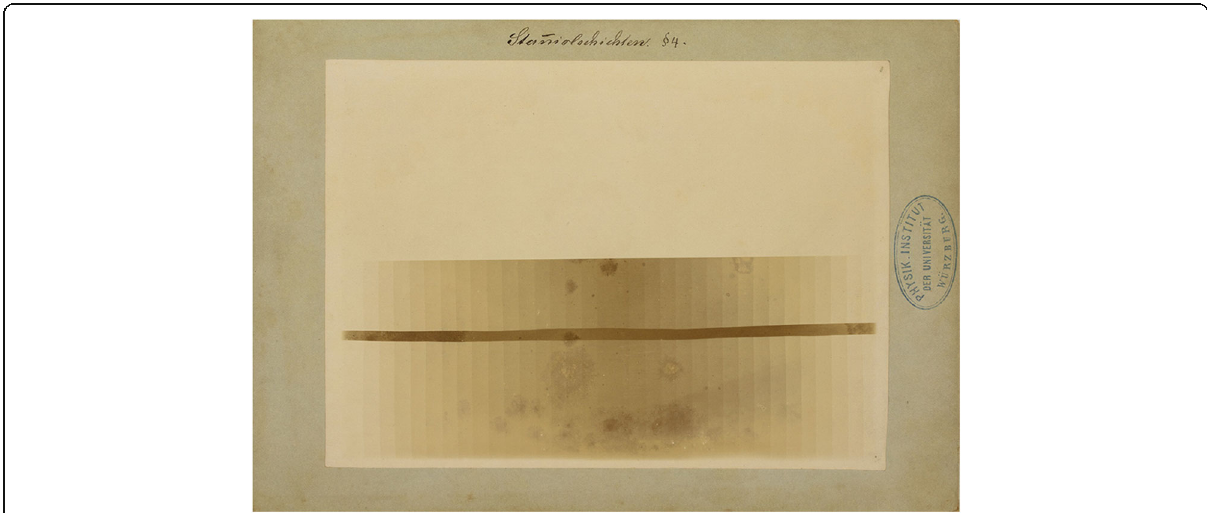
Fig. 5 Stacks of tin foil with various thicknesses. This image shows that the thicker the stack, the less X-radiation passes through it.